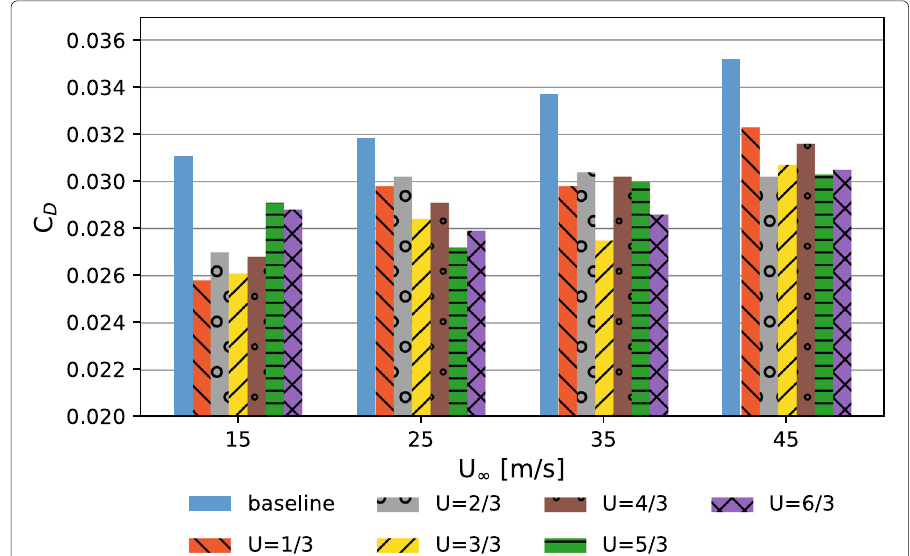
Fig. 21 Time-averaged drag coefficient for the front wheels only with 45 ◦ air-jet wheel